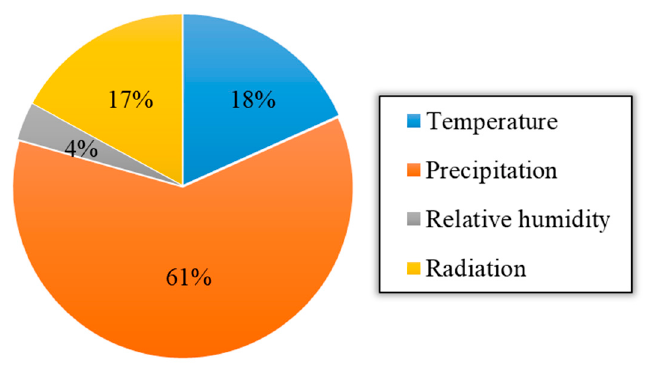
Figure 12. The relative contribution rate of meteorological factors to NEP.